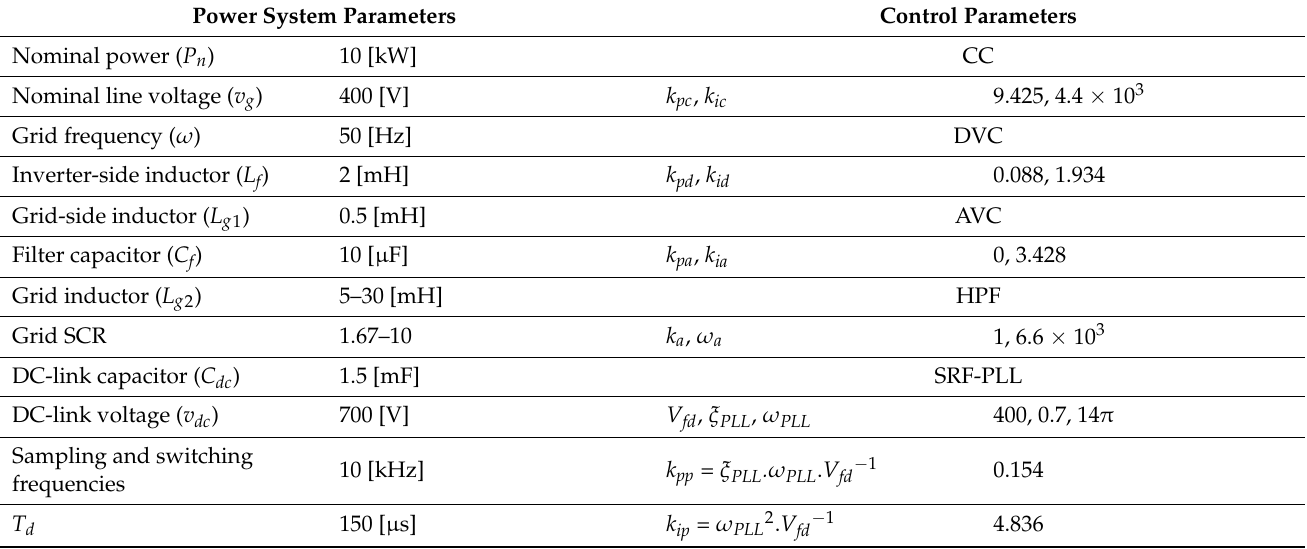
Table 2. System and control parameters of the main power system.